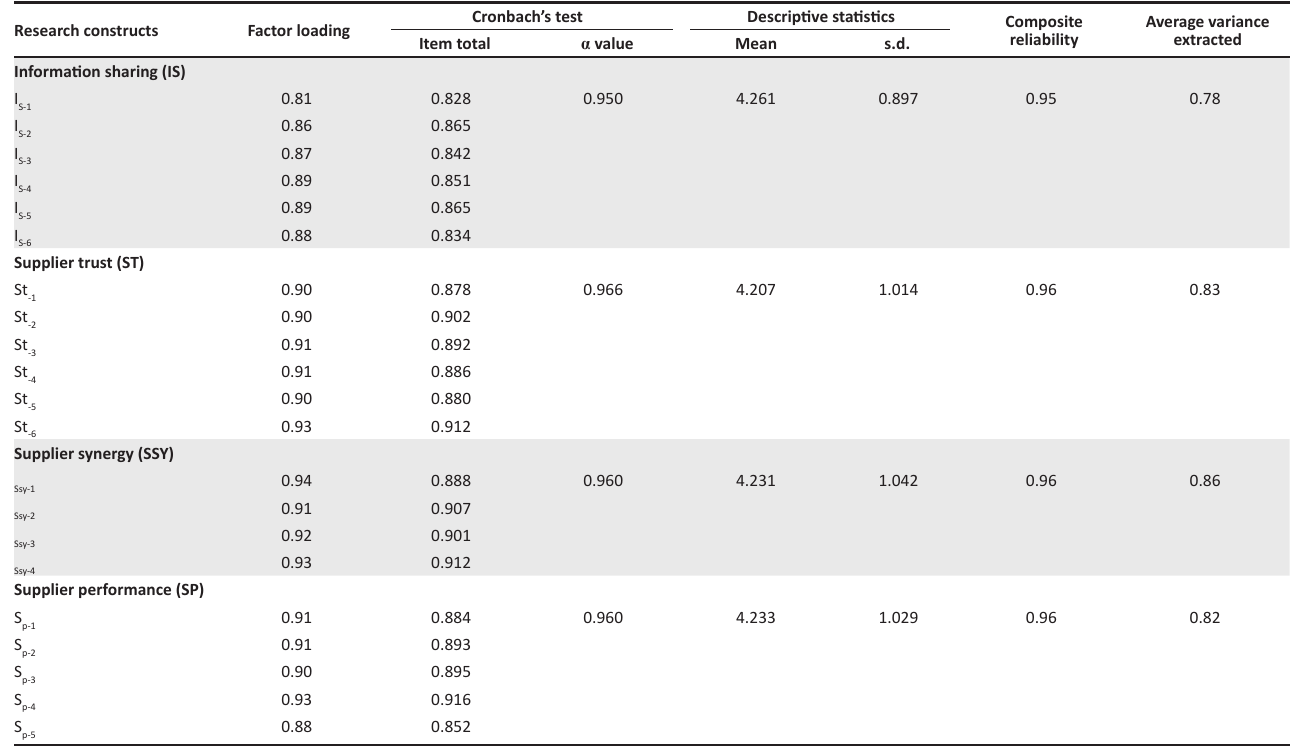
TABLE 2: Accuracy analysis statistics. Research